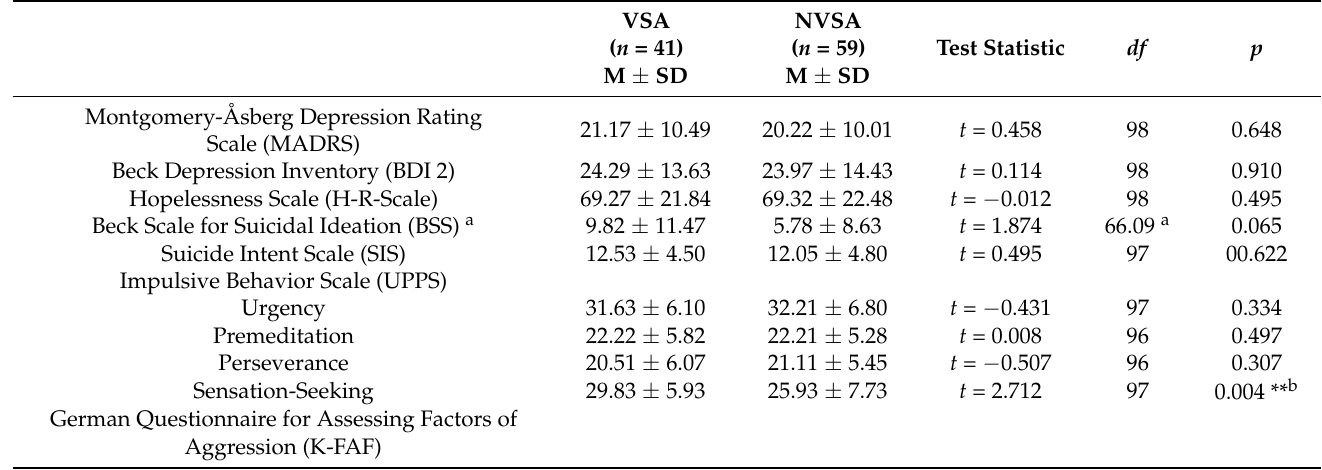
Table 2. Comparison of clinical characteristics between suicide attempters who used a violent suicidal means and those who only used non-violent suicidal